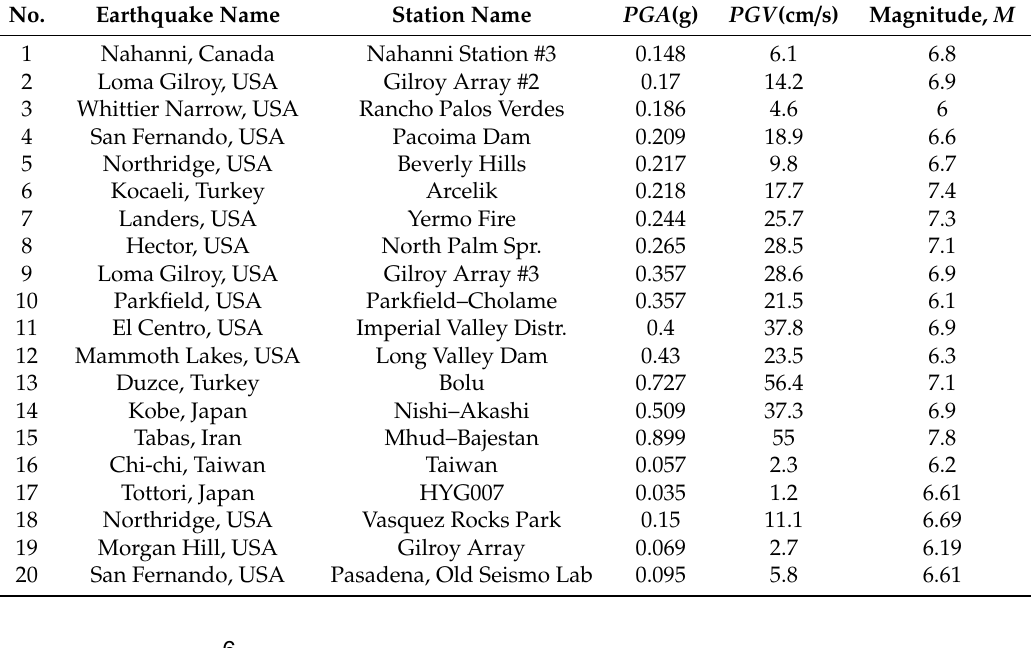
Table 3. Details of input ground motion selected to perform nonlinear dynamic analyses.